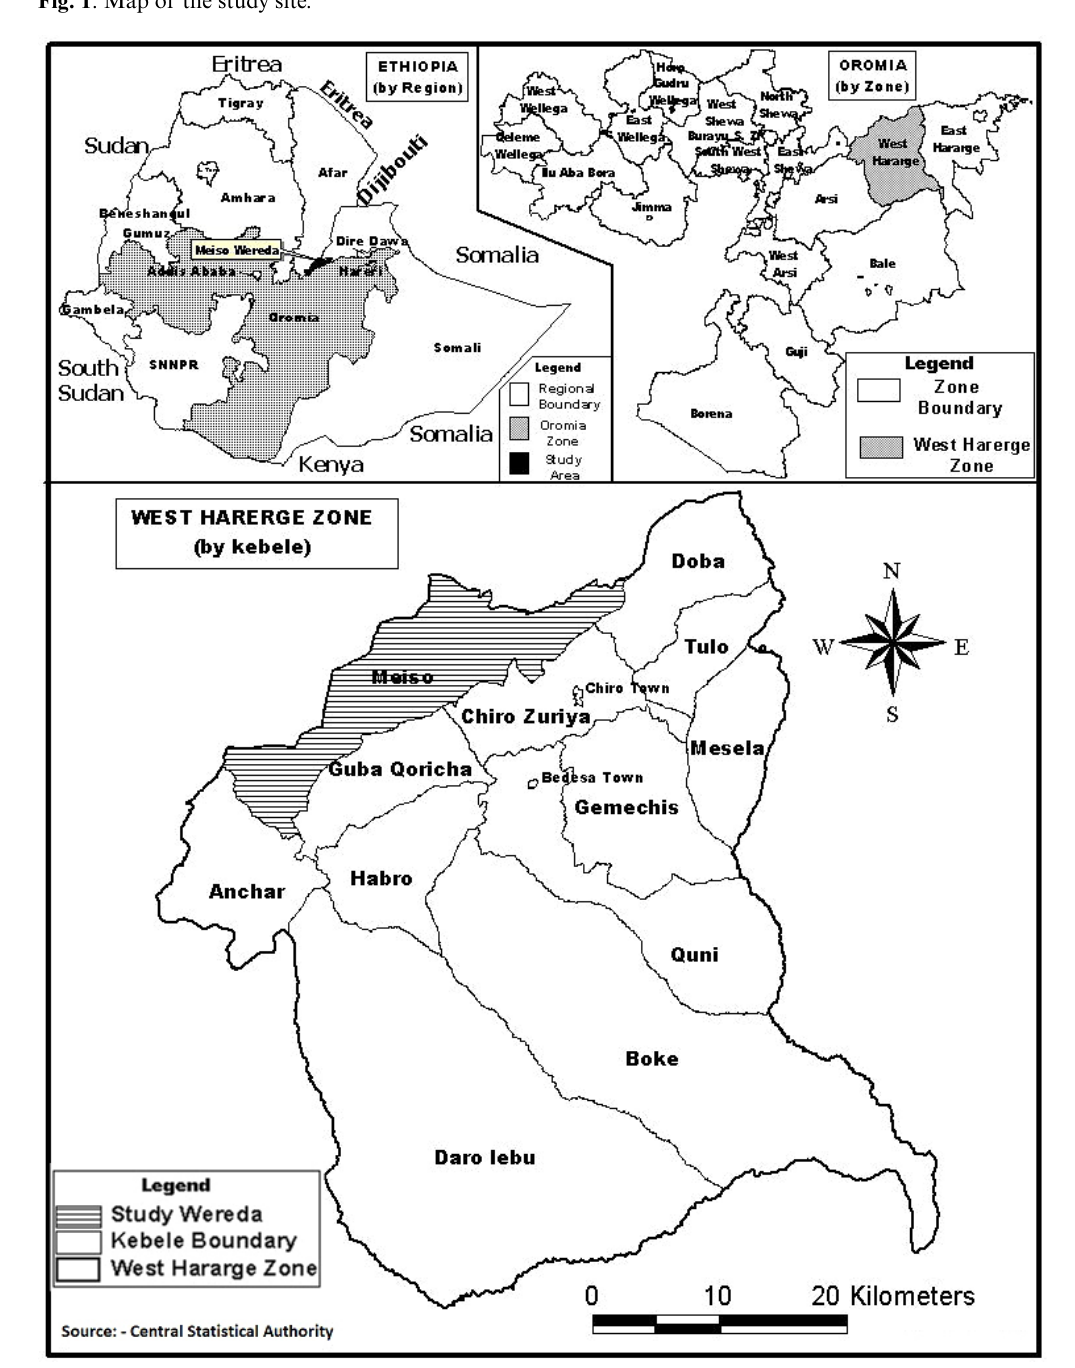
Fig. 1 . Map of the study